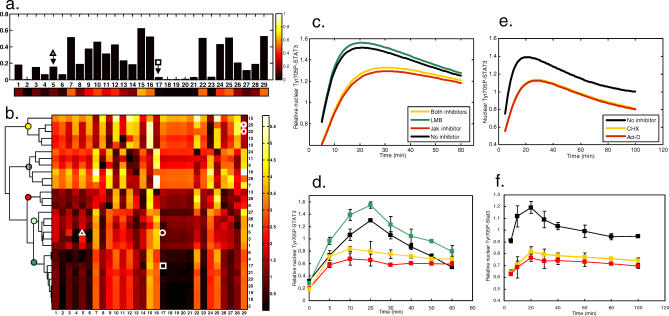
Global Sensitivity Analysis Based on Stat3 Activation(A) Individual rate constants were changed 5-fold, and a Euclidean distance measurement was used to determine the resultant change in the Stat3 activation profile. Normalized Euclidean distance measurements are plotted to show the sensitivity of Stat3 activation to each parameter.(B) Global sensitivity analysis results show changes in Stat3 activation (measured by Euclidean distance) due to 5-fold changes in combinations of parameters pairs, shown along the x- and y-axis. The sensitivity is represented using color code, with corresponding Euclidean distance values shown in the color bar. Hierarchical clustering (indicated on the left) is based on correlations between rows of rate constants to demonstrate groups of parameters which interact similarly. Clustering was perfomed using Matlab software by Mathworks. Rate constants, which are grouped together, are color-coded using circular dots, and the color code is included in Figure 1. Sensitivity analysis predictions for the Stat3 nuclear export parameter (marked by square), and receptor phosphorylation (marked by triangle), and their interaction (marked by circle) are shown in (C). Sensitivity trends which were predicted in (C) are experimentally verified (D), demonstrating that predicted trends are relevant.(E) Sensitivity analysis trends of interaction of SOCS3 transcription and receptor production (marked by hexagon) and SOCS3 translation and receptor production (marked by cross) are in agreement with experimental results shown in (F).